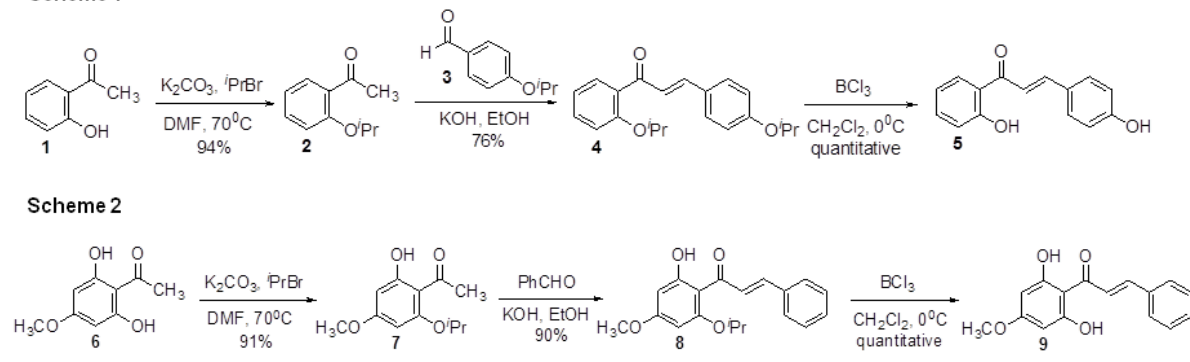
Figure 1. Synthesis of compound 5 and compound 9